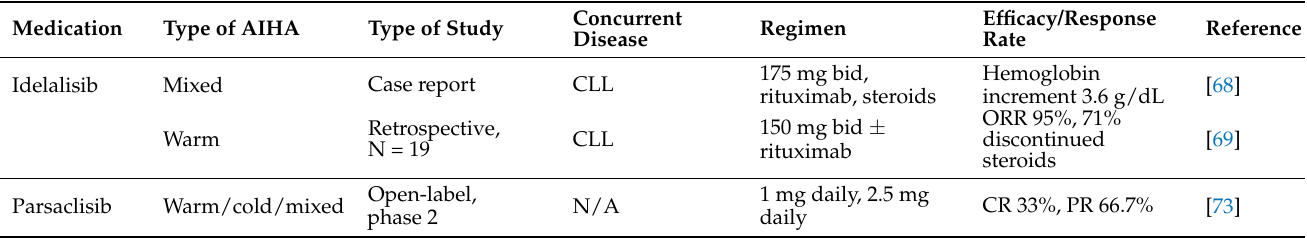
Table 1. B-cell-directed